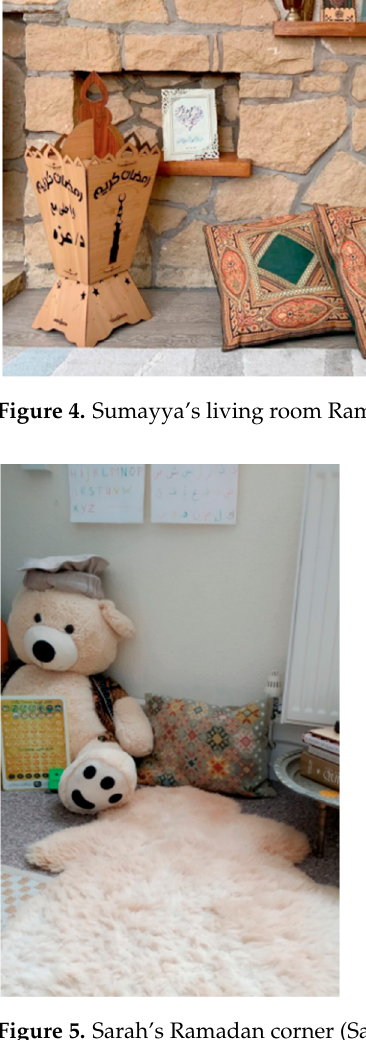
Figure 5. Sarah’s Ramadan corner (Sarah, Diary Image, Entry 2).